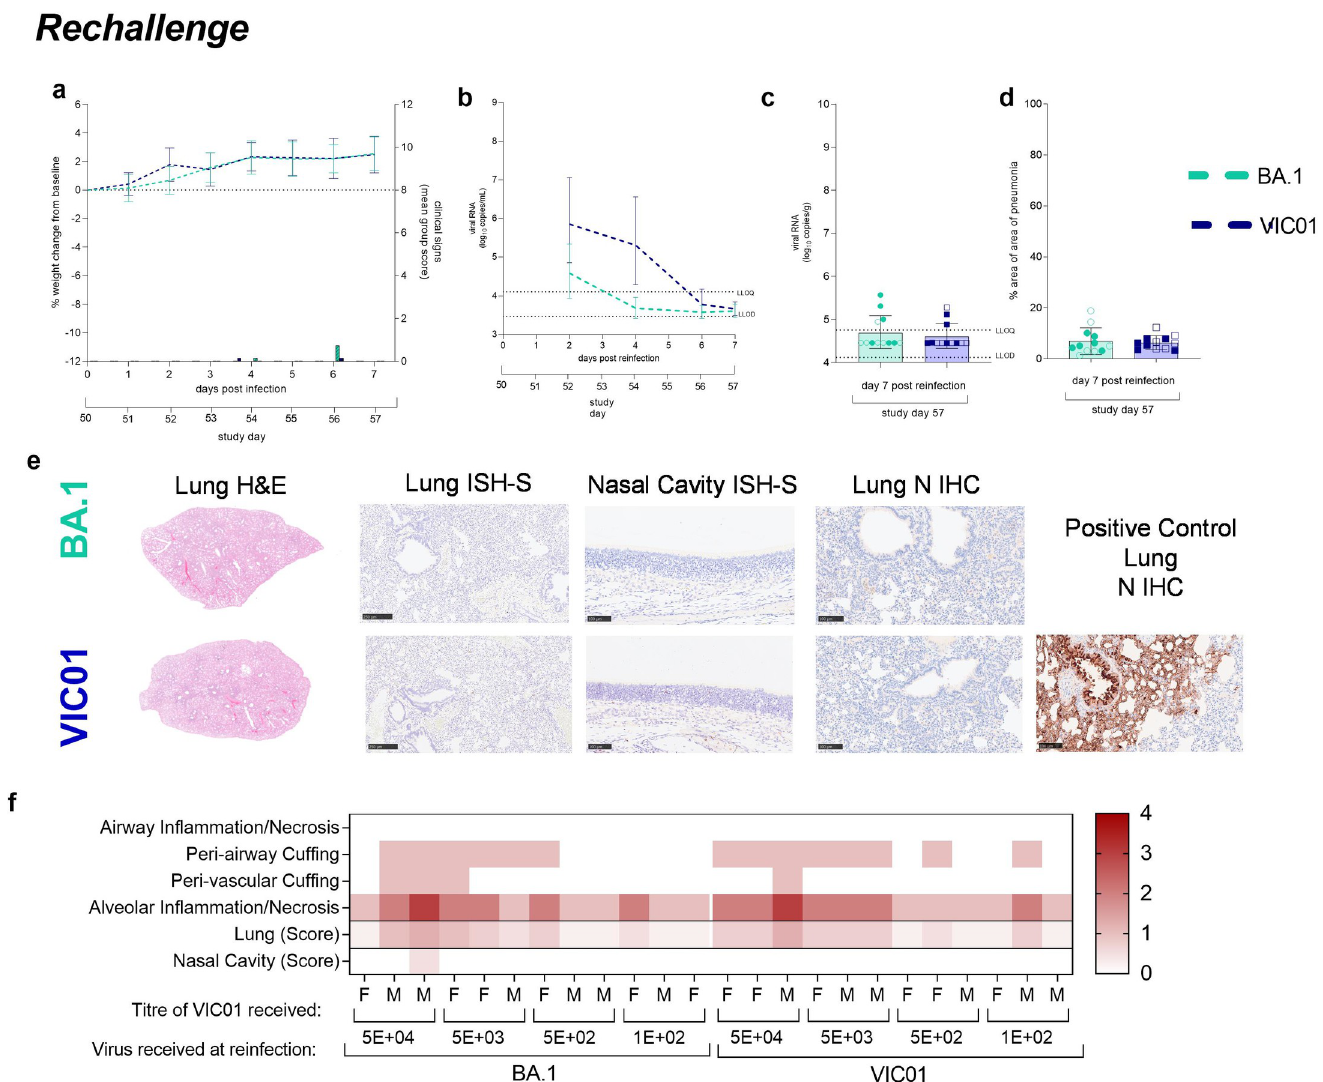
Fig 4. Rechallenge of hamsters with SARS-CoV-2 Hamsters were monitored for ( a ) weight change (lines show group means, error bars show standard deviation). and clinical signs (bars). Bars show average assigned clinical score. No differences in weight change were found between hamsters rechallenged with VIC01 or the BA.1 variant. ( b ) Total viral RNA was quantified by RT-qPCR. Lines show group means and error bars show standard deviation. BA.1 rechallenged hamsters shed significantly less (P = 0.0005) viral RNA from their URT by day 4 compared to VIC01 rechallenge hamsters. Statistical analysis between groups was carried on log base - transformed data using RM-ANOVA. The dashed horizontal lines show the lower limit of quantification (LLOQ) and the lower limit of detection (LLOD). Following necropsy ( c ) viral load was quantified in the lungs of hamsters. There was no detectable difference in total viral RNA found in the lungs of hamsters rechallenged with either BA.1 or VIC01. Bars show group means and error bars show standard deviation. The dashed horizontal lines show the lower limit of quantification (LLOQ) and the lower limit of detection (LLOD). Closed symbols show males and open symbols show females. Pathological examination revealed no differences between the ( d ) percentage area of pneumonia in BA.1 or VIC01 infected hamsters. Bars show group means and error bars show standard deviation. Closed symbols show males and open symbols show females. ( e ) Examples of lung H&E staining, lung in-situ hybridisation (bar = 250 μ m), nasal cavity ISH detection of viral RNA (bar = 100 μ m) and IHC staining viral N protein of lung (bar = 100 μ m) and nasal cavity (bar = 100 μ m) in hamsters rechallenged with either BA.1 or VIC01. ( f ) Pathological examination showed no differences between the lung histopathology score and nasal histopathology score in hamsters rechallenged with either BA.1 or